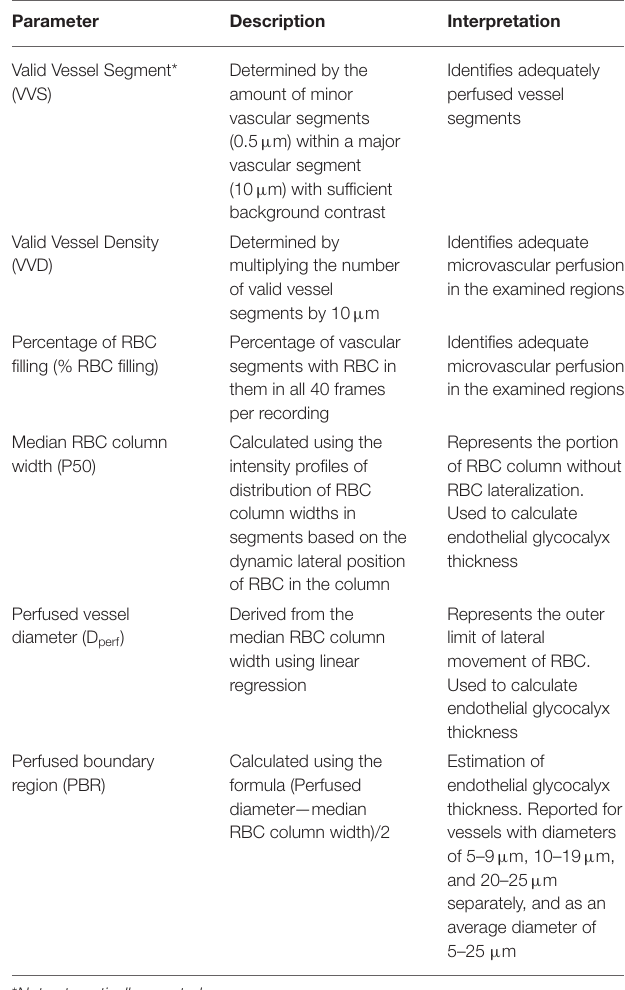
TABLE 1 | Description and interpretation of GlycoCheck ®